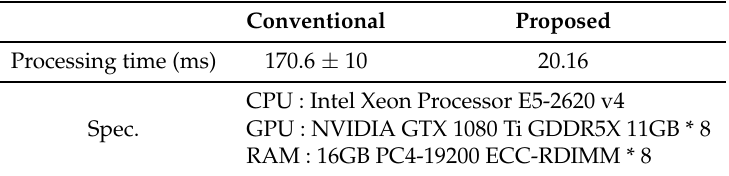
Table 5. Computational-time comparison.